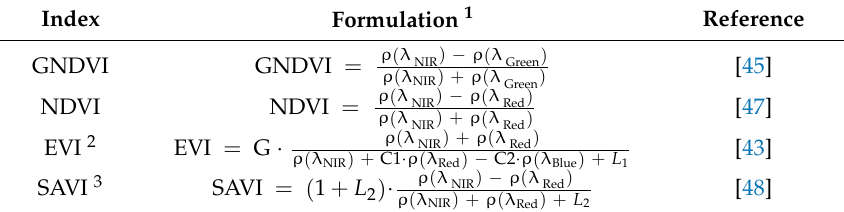
Table 1. Formulation and source of the four vegetation indices used in this